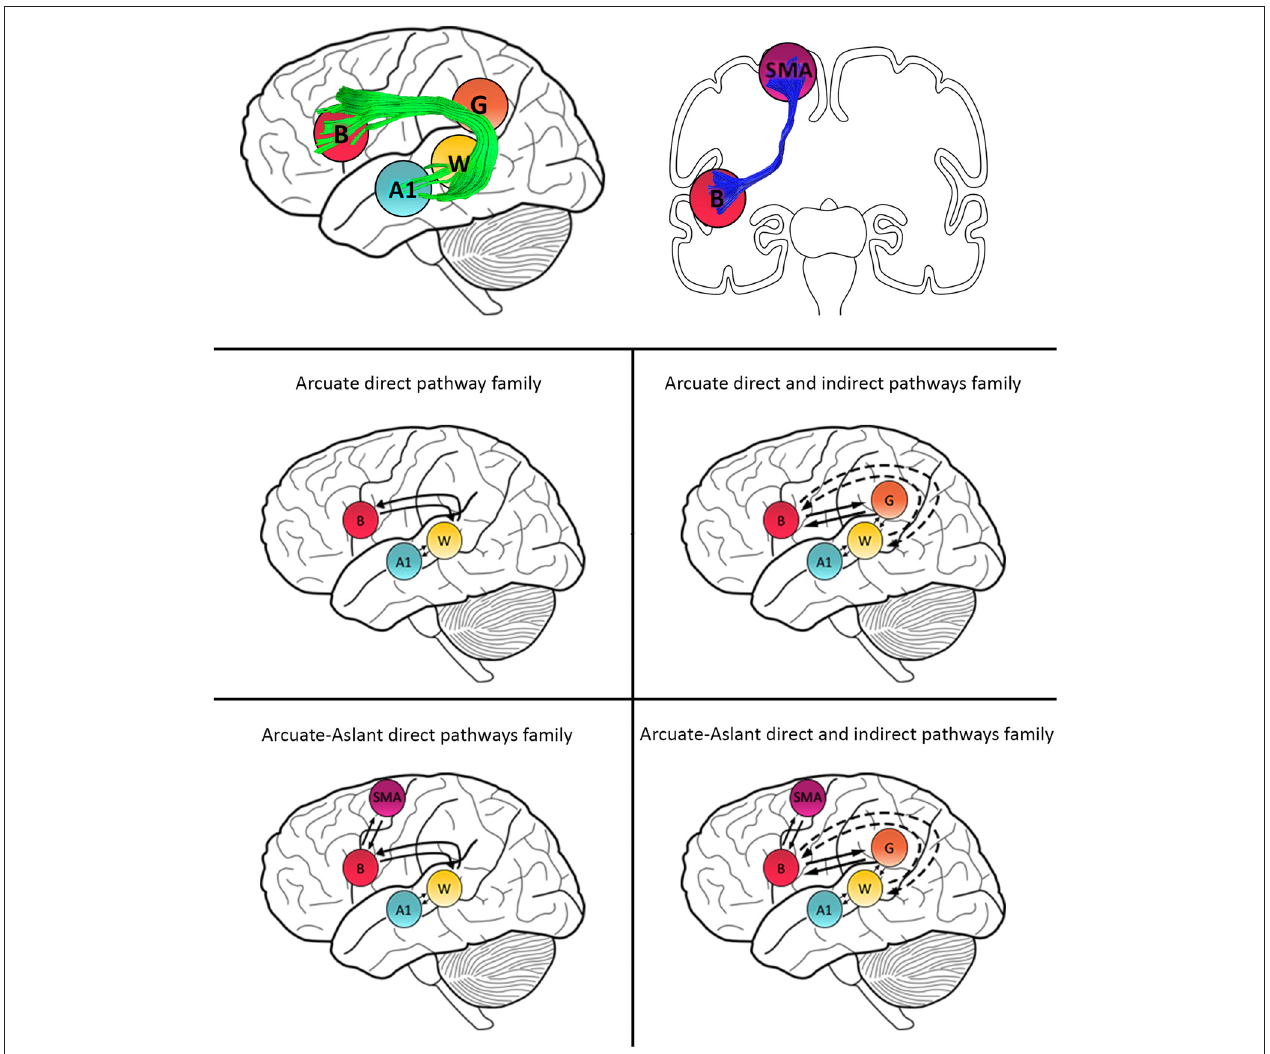
FIGURE 2 | Schematic representation of family definitions and anatomical white matter pathways. Primary auditory cortex (A1), Wernicke’s area (W), Geschwind’s territory (G) and Broca’s area (B) are interconnected via the arcuate fasciculus (green). B and SMA are interconnected by the frontal aslant